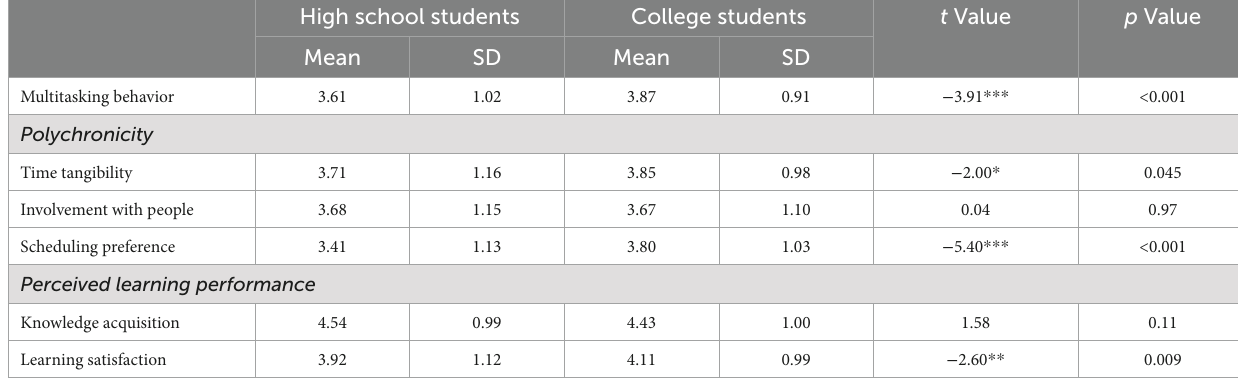
TABLE 2 T test of multitasking, polychronicity, and perceived learning performance across educational